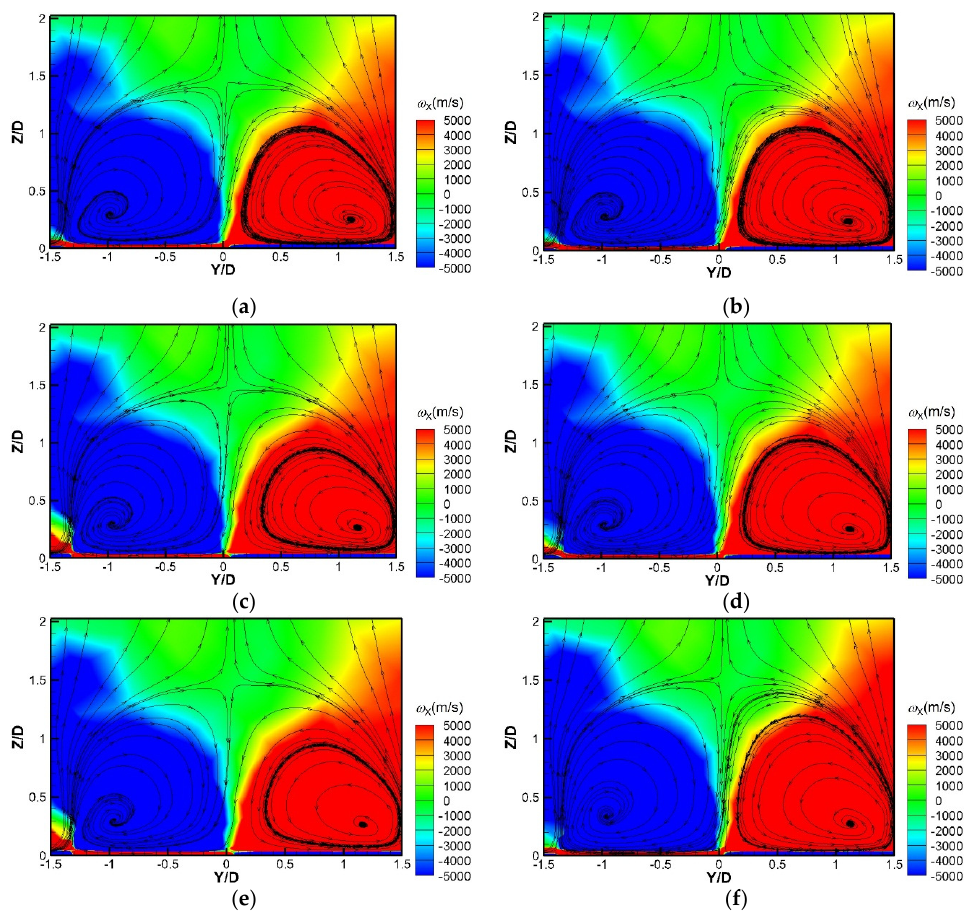
Machines 2022 , 10 , x FOR PEER REVIEW 15 of 19 Figure 12. Streamlines and streamwise vorticities over the surface X/D = 5 with various heat con- Figure 12. Streamlines and streamwise vorticities over the surface X/D = 5 with various heat conduc- ductivities at M = 1.5. ( a ) Bi = 0.026; ( b ) Bi = 0.065; ( c ) Bi = 0.13; ( d ) Bi = 0.26; ( e ) Bi = 0.65; ( f ) adiabatic. tivities at M = 1.5. ( a ) Bi = 0.026; ( b ) Bi = 0.065; ( c ) Bi = 0.13; ( d ) Bi = 0.26; ( e ) Bi = 0.65; ( f ) adiabatic. The non-dimensional temperature contours over the cross-section plane Y / D = 0 in the fluid and solid domains are given in Figure 13. When the solid heat conduction is considered, the coolants are heated by the mainstream hot air through the flat plate, in- creasing the temperature at the hole entrance. As the Biot number increases from 0.026 to 0.65, the area-averaged non-dimensional temperature at the hole entrance varies from 0.076 to 0.062, equal to 10.86K. Moreover, the Biot number significantly influences the temperature distribution in the flat plate near the hole. The coolant temperature inside the hole and the solid inner temperature near the hole with a high Biot number are lower than those with a low Biot number. The temperature gradient in the solid domain is higher at a higher Biot number, resulting in the possible higher thermal stress.